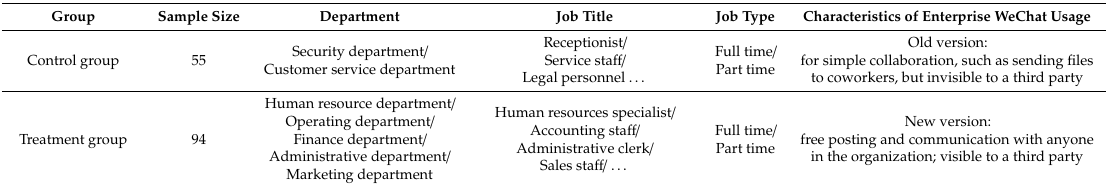
Table 1. Demographic characteristics of